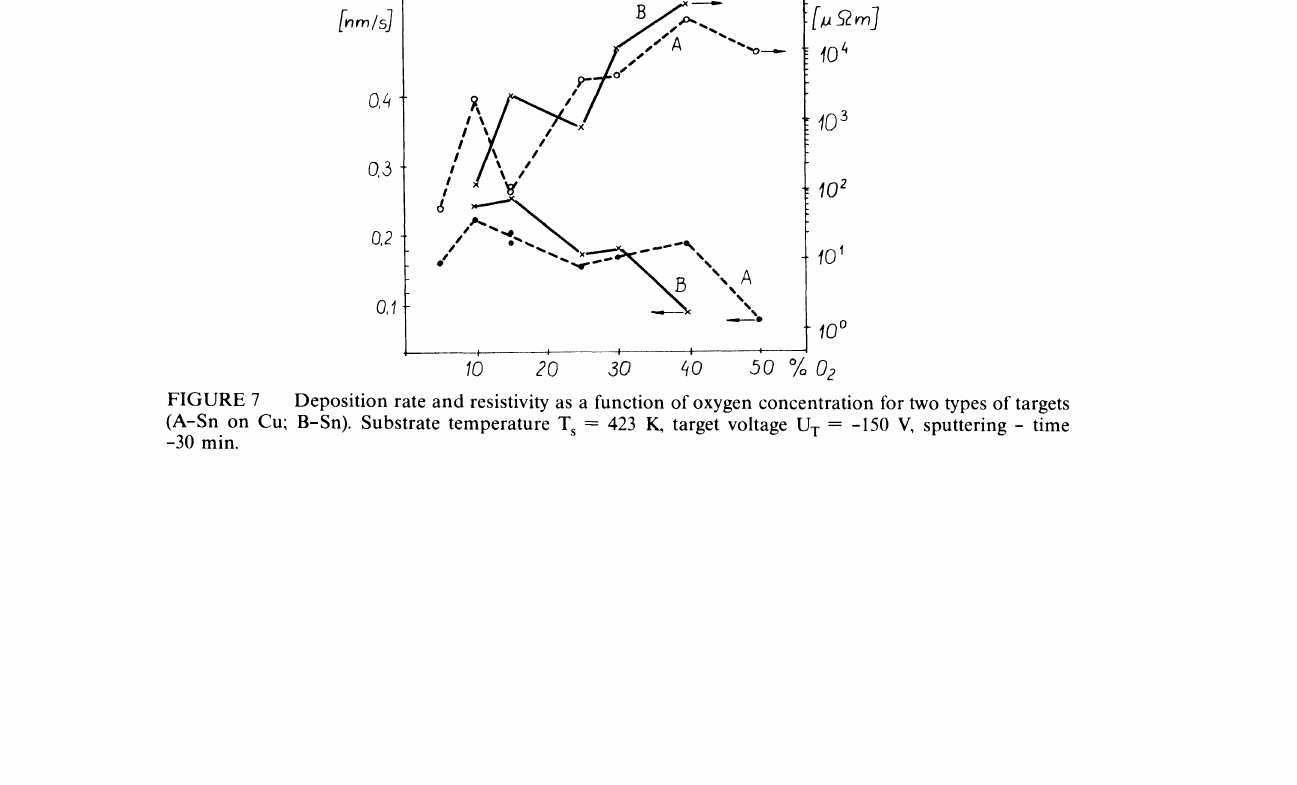
V, sputtering time T -150